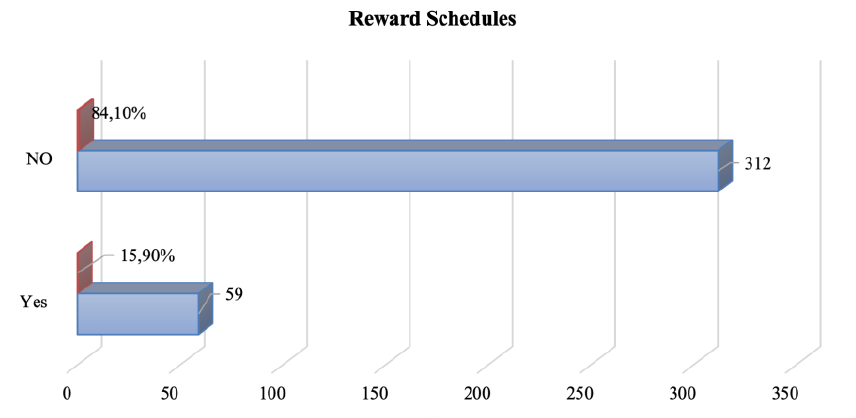
Figure 4: Reward Schedules; Source: Survey Data (2021)